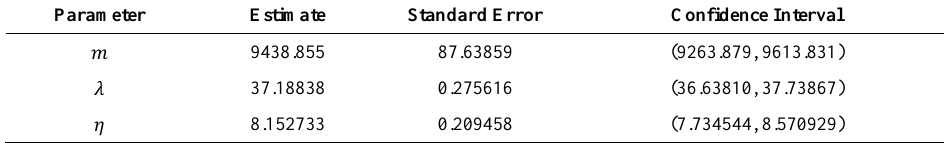
Table A19. Tuscany. Estimates, asymptotic standard errors and 95% mCIs for the parameters of the LOG model (2).